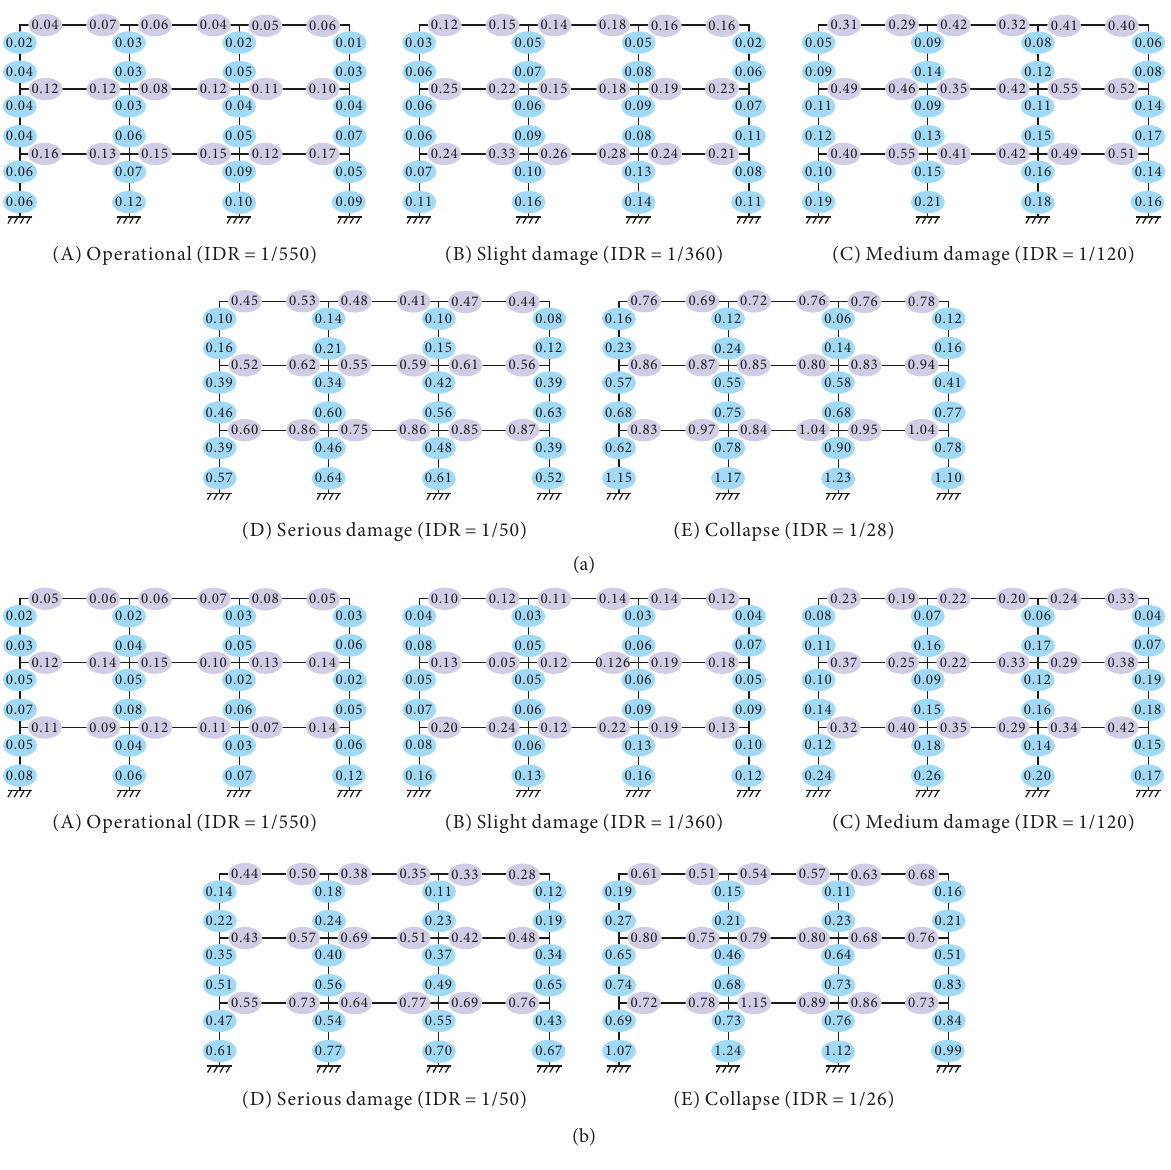
Figure 12: Damage distribution of test frames. (a) KJ-1. (b) KJ-2.